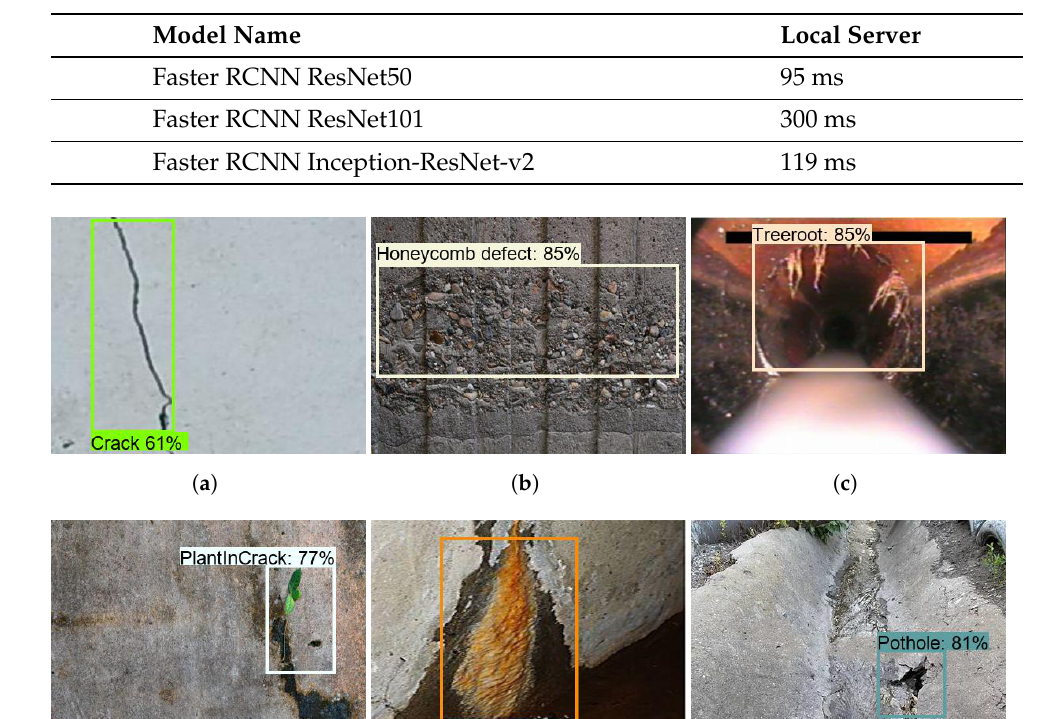
Table 4. Computationaltime analysis.